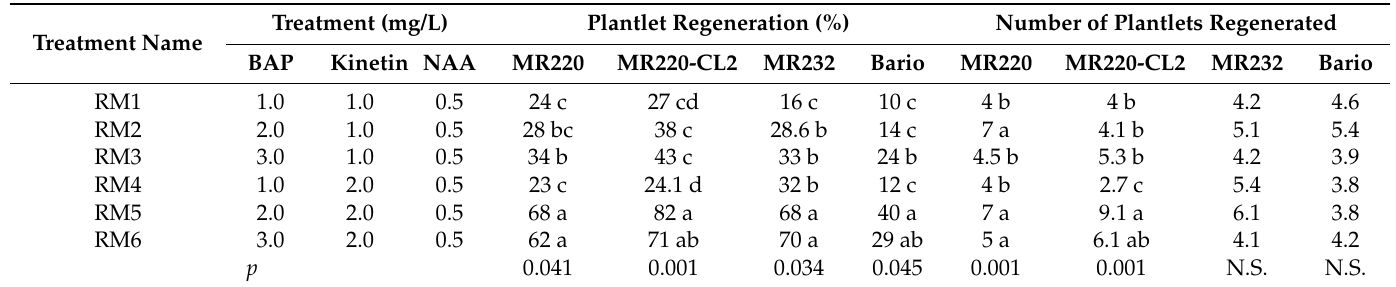
Table 2. The effect of different concentration (mg/L) of BAP (6-benzylaminopurine) + Kinetin + 0.5 NAA in MS (Murashige and Skoog) medium on plantlet regeneration (%) from the calli of four different Malaysian indica rice